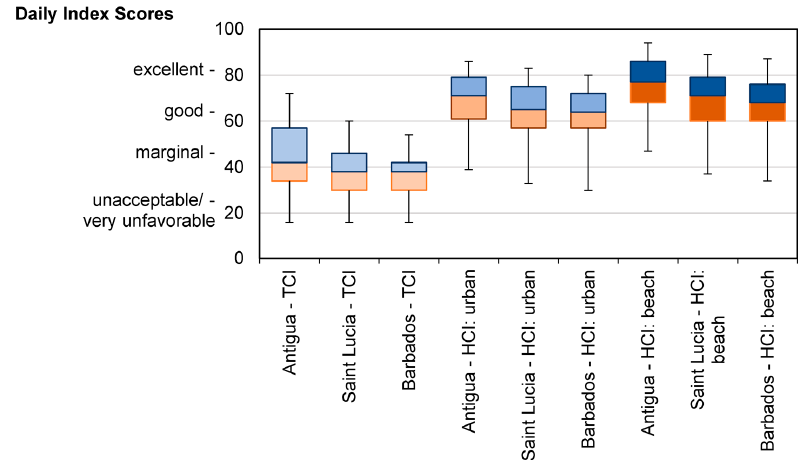
Figure 2. Daily index scores for Tourism Climate Index (TCI), Holiday Climate Index (HCI): Urban, and HCI: Beach for Caribbean destinations (whiskers represent the 5th and 95th percentiles) (adapted from [1]).